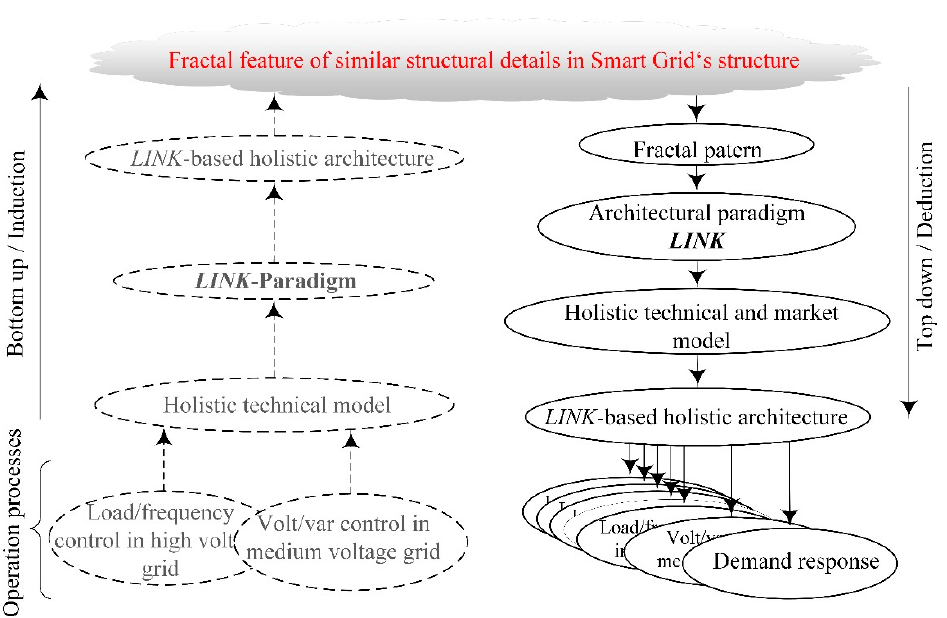
Figure 1. The methodology used to design the smart grids architecture and the market structure.